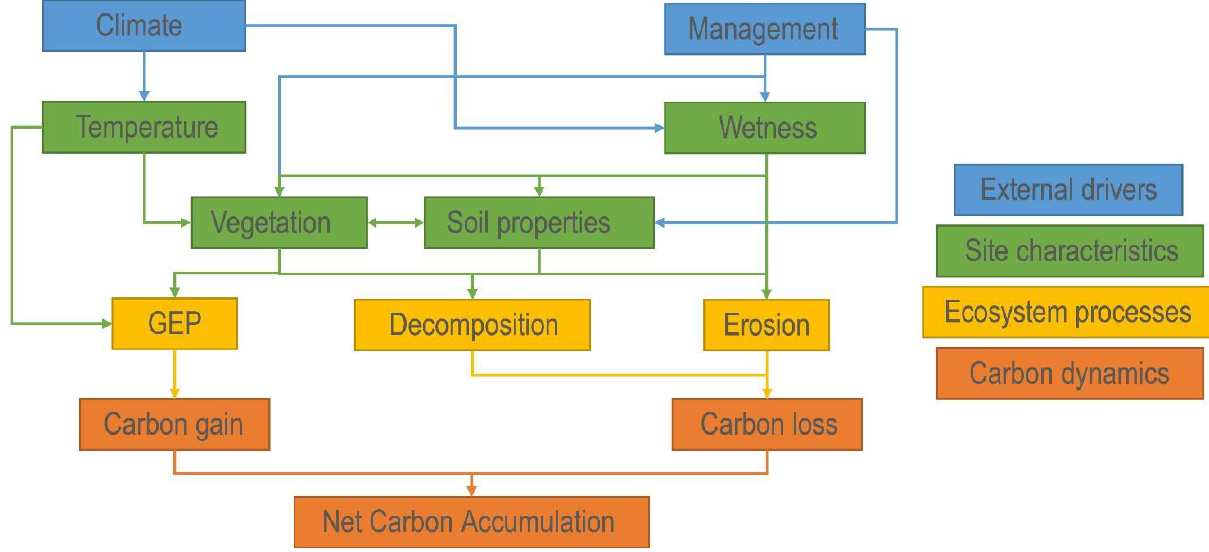
Figure 2. A conceptual diagram of variables influencing net carbon